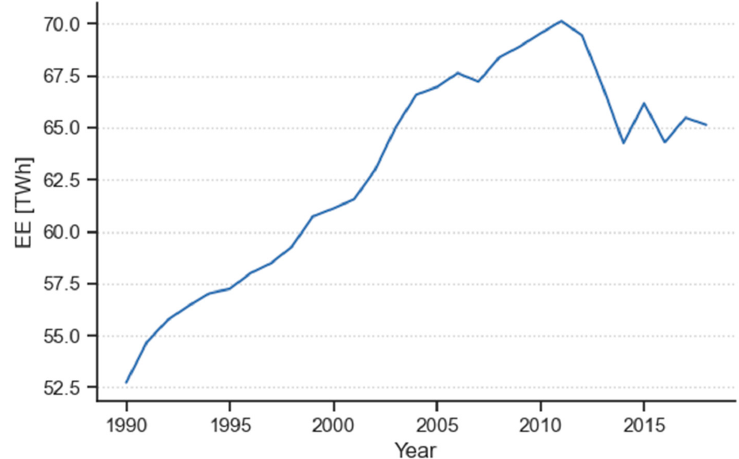
Figure 1. Electricity consumption of the Italian residential sector from 1990 to 2018 [9].